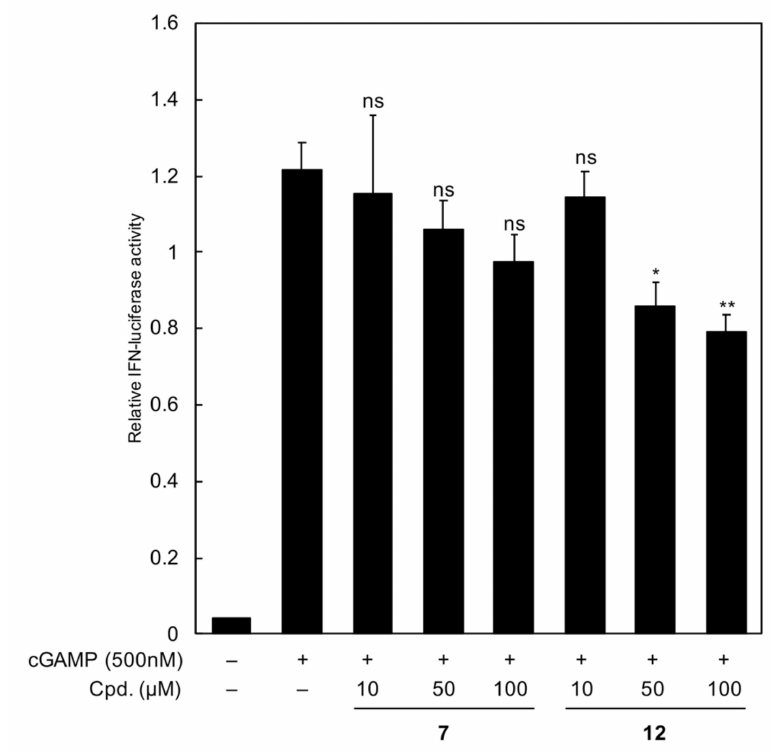
Figure 3. Evaluation of the IFN- β inhibition activity of compounds 7 and 12 with digitonin perme- abilization. HEK293T cells were transfected with vectors encoding STING, as indicated, together with an IFN-luciferase reporter, and luciferase activity was measured 6 h after stimulation. Data are presented as mean ± SEM ( n = 3). * p < 0.05; ** p < 0.005; and ns mean statistically no significance when compared with the cGAMP-treated control in a Student’s